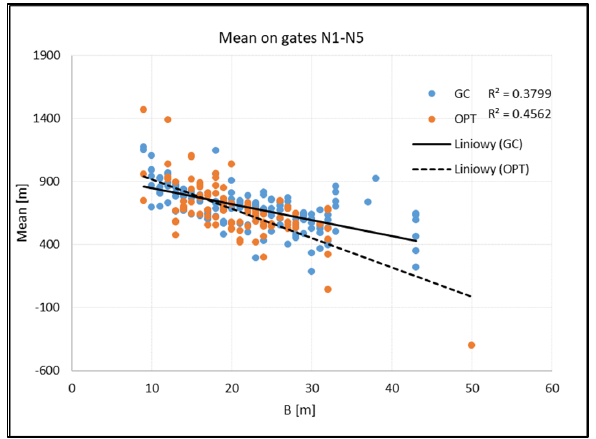
Figure 8. ( a ) The mean of the ship’s distance from the centre; ( b ) standard deviation of ship distance from the centre to the ship’s draught.